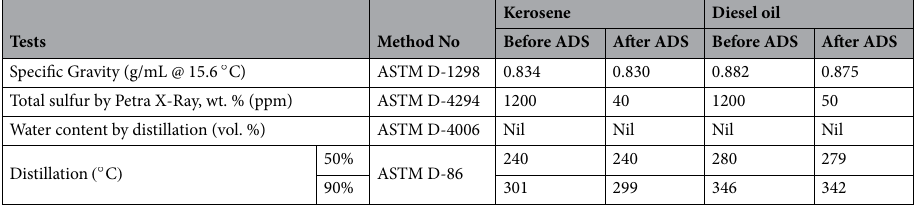
Table 4. ADS of kerosene and diesel oil onto B-BTC.